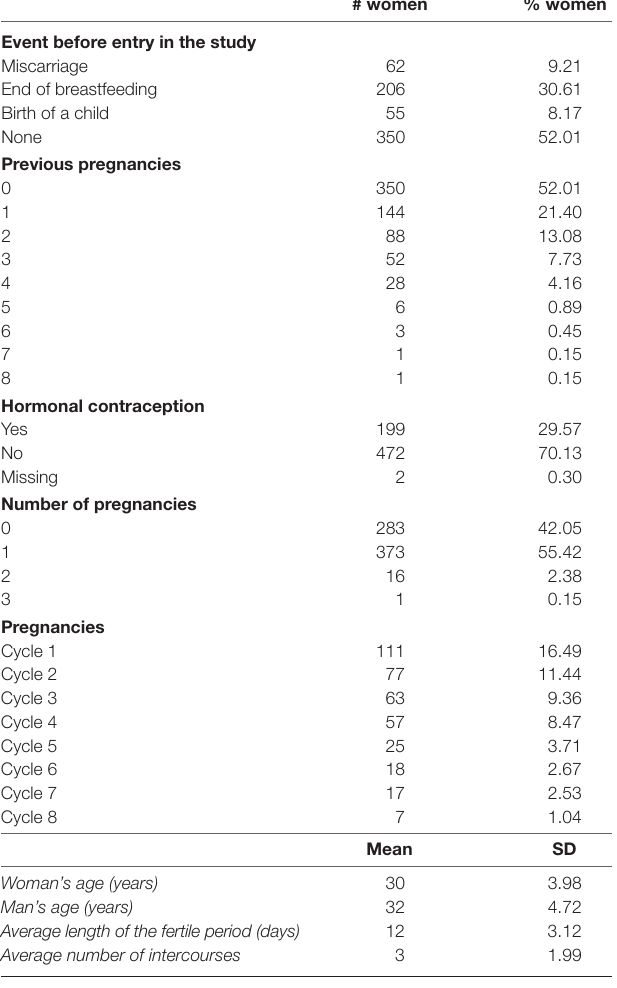
Table 3 | Descriptive statistics of the data.